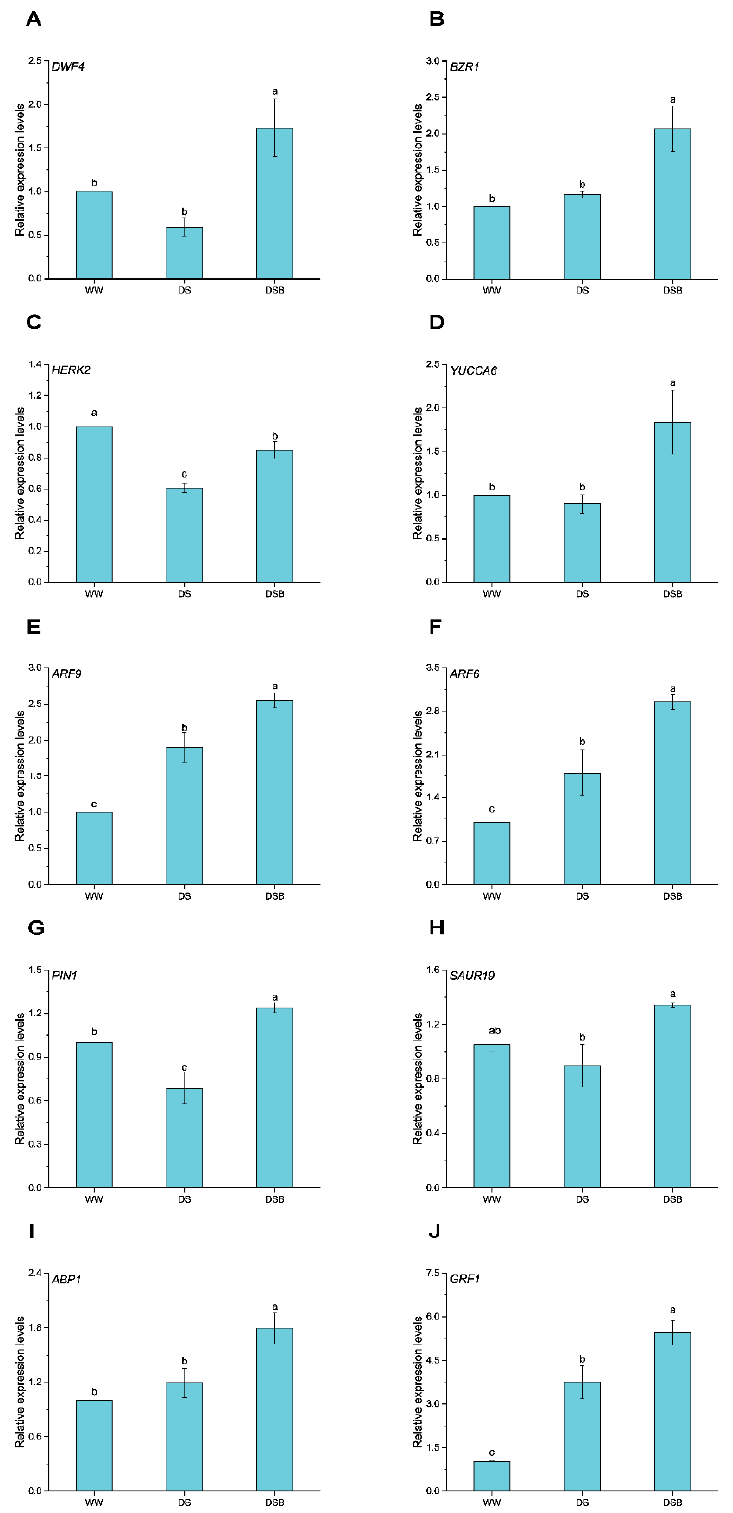
Figure 3. Cell-expansion-related gene expression is mediated by the BR and IAA signaling pathways. This figure comprises gene expressions such as DWF4 ( A ), BZR1 ( B ), HERK2 ( C ), YUCCA6 ( D ), ARF9 ( E ), ARF6 ( F ), PIN1 ( G ), SAUR19 ( H ), ABP1 ( I ), and GRF1 ( J ). The data are presented as means ± SE in the three treatments including WW (well-watered), DS (drought stress), and DSB (drought stress + 0.05 mM 2,4-epibrassinolide application). Error bars represent SE of the mean; different letters on bars show significant differences at p < 0.05 using the LSD test.